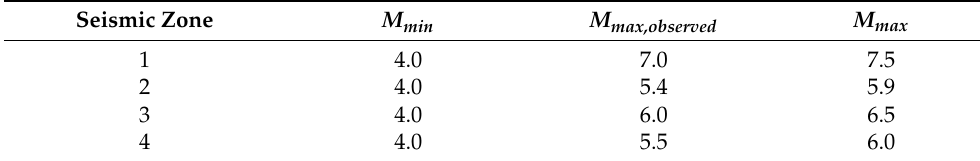
Table 4. M min and M max for each seismic zone.